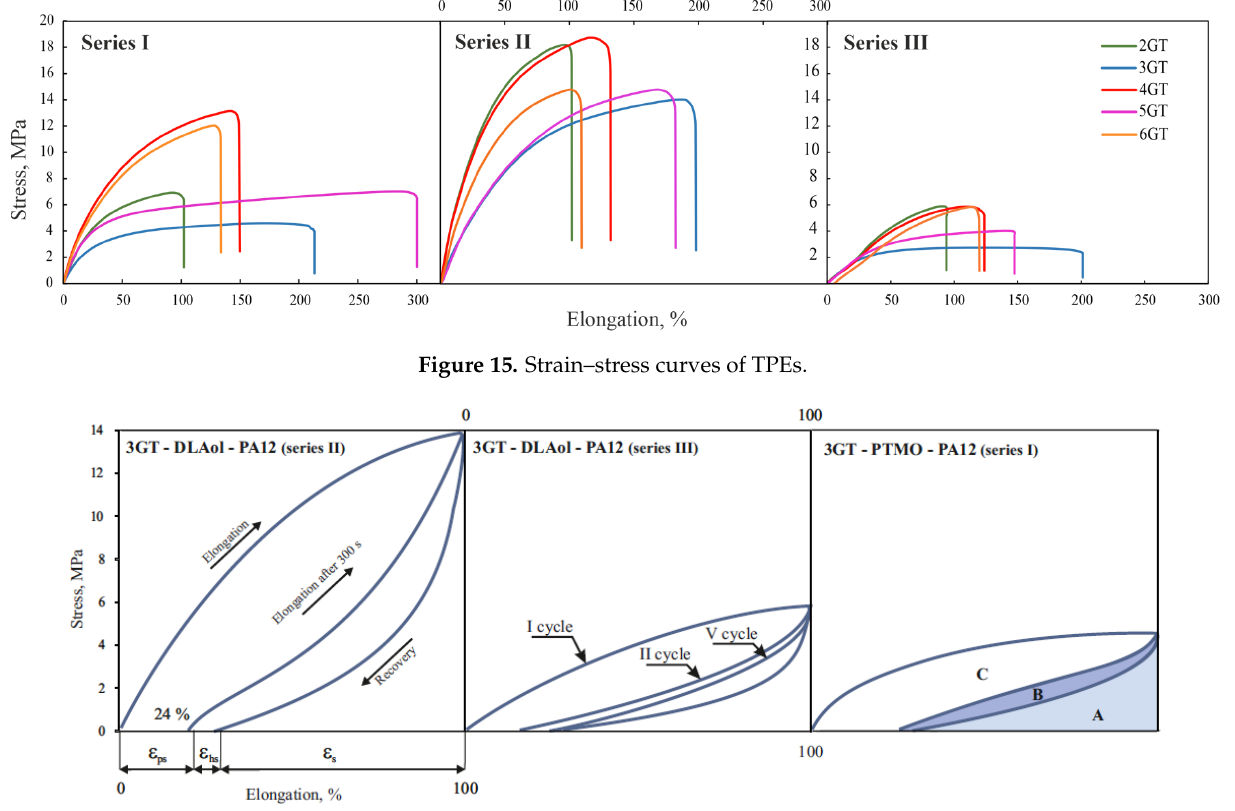
Figure 16. Mechanical hysteresis loops at a constant elongation of 100% of terpoly(ester-aliphatic-amide) of series II and terpoly(ester-ether-amide) of series I, where the ester block was 5GT: ε s —elastic elongation; ε hs —delayed high-elastic elongation; ε ps —permanent elongation; A—area proportional to the elastic energy dispersed; B—area proportional to the high-elastic energy dispersed; C—area proportional to the energy accumulated.